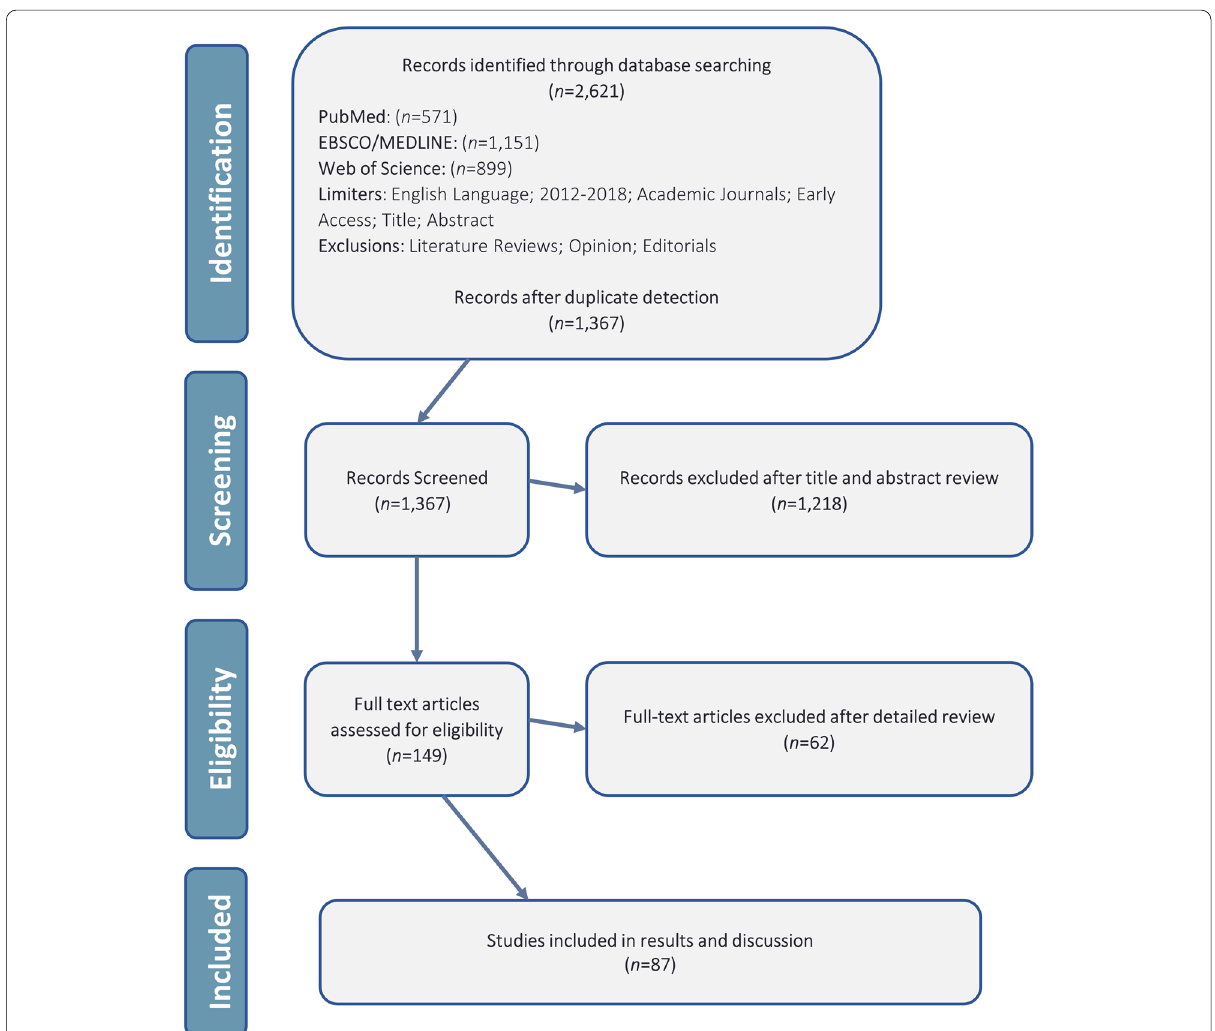
Fig. 1 PRISMA flow diagram for emerging TJA